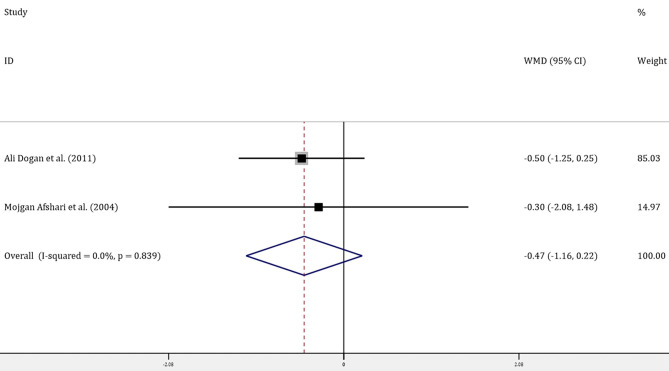
Forest plot of meta-analysis of the effect of ULT with allopurinol on HbA1c. Data are pooled WMDs with 95% CIs. ULT, uric acid-lowering therapy; HbA1c, glycated hemoglobin A1c; WMD, weighted mean difference; CIs, confidence intervals.